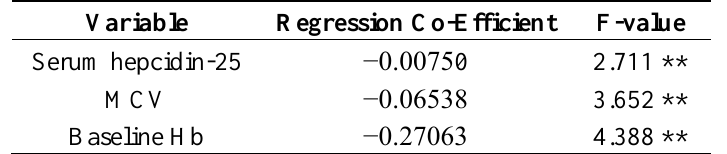
Table 5. Contribution of variables * to OIT response with ΔHb increment evaluated by stepwise multiple linear regression analysis.